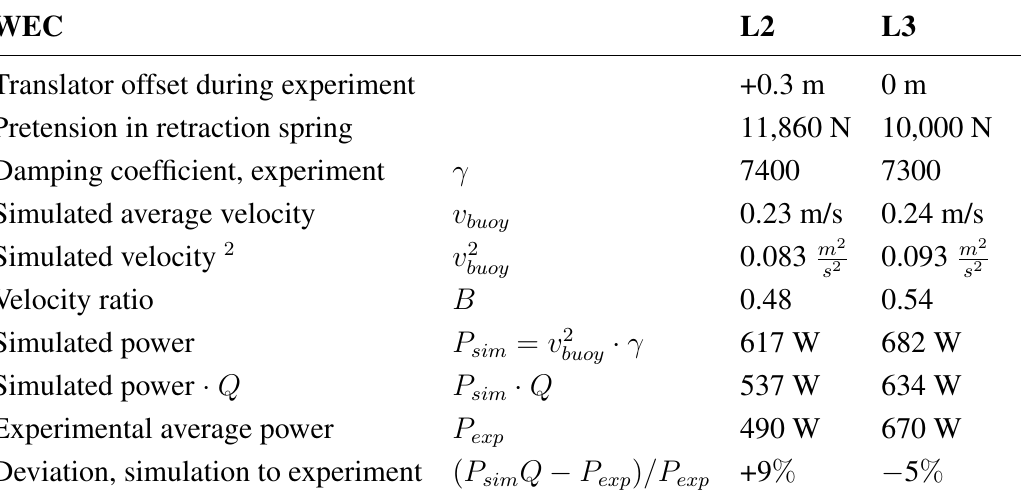
Table 2. Simulated absorption and experimental power for L2 and